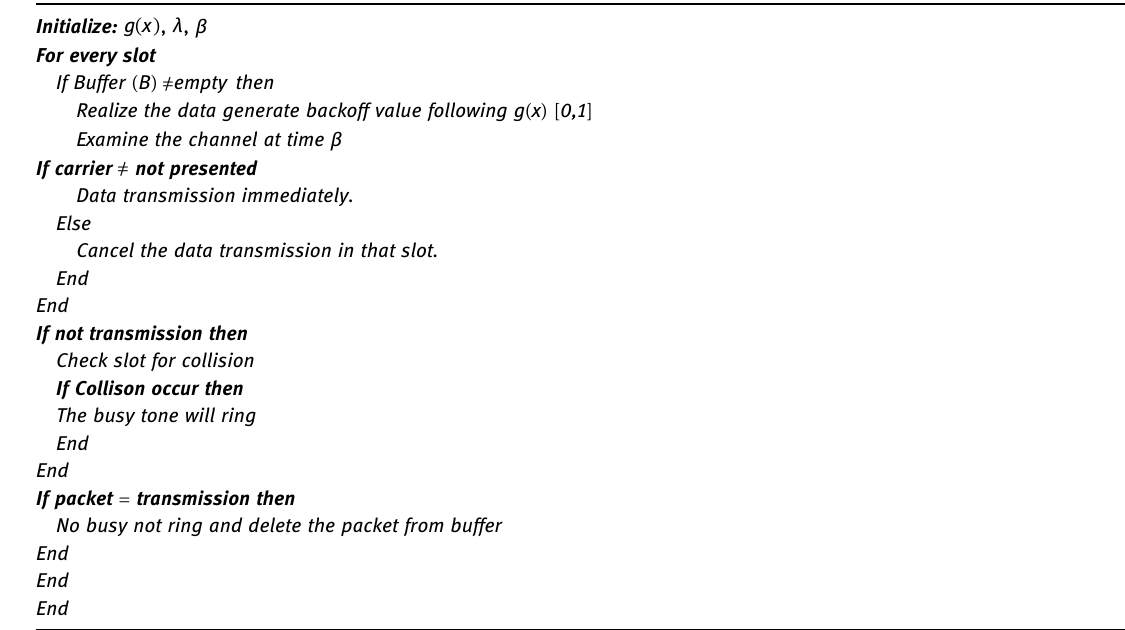
Table 1: Channel access